Question: Produce a descriptive caption suitable for publication.
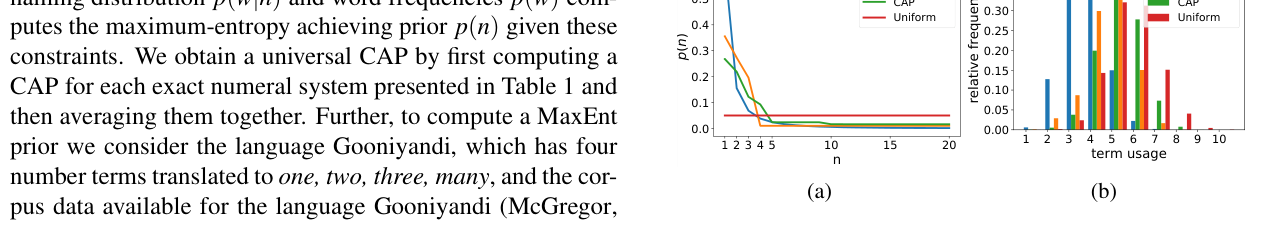
Answer: a) The need probabilities, or priors, used. b) Rel- ative frequency of term uses over sender-listener pairs using the linear reward function and varying the need probability. The more left-skewed the need probability is, the fewer terms are generally used by the agents.